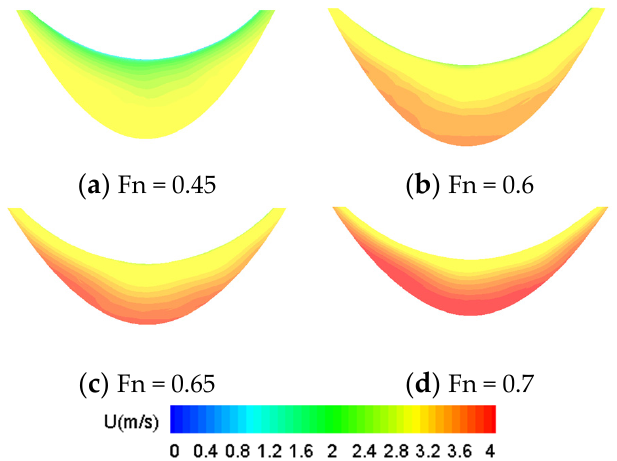
Figure 23. The velocity distribution on the capture area. Figure 24. The difference between the simulated volume flow rate and the experimental results provided by the two institutes is less than